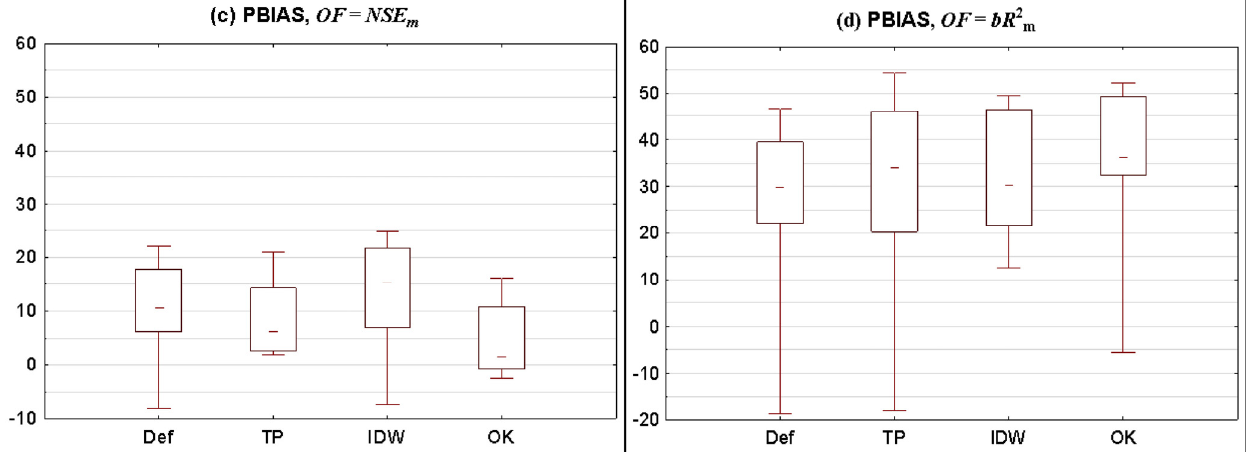
Figure 7. Box plots of PBIAS across all 11 flow gauging stations for different interpolation methods (Def—Default version, TP—Thiessen Polygons, IDW—Inverse Distance